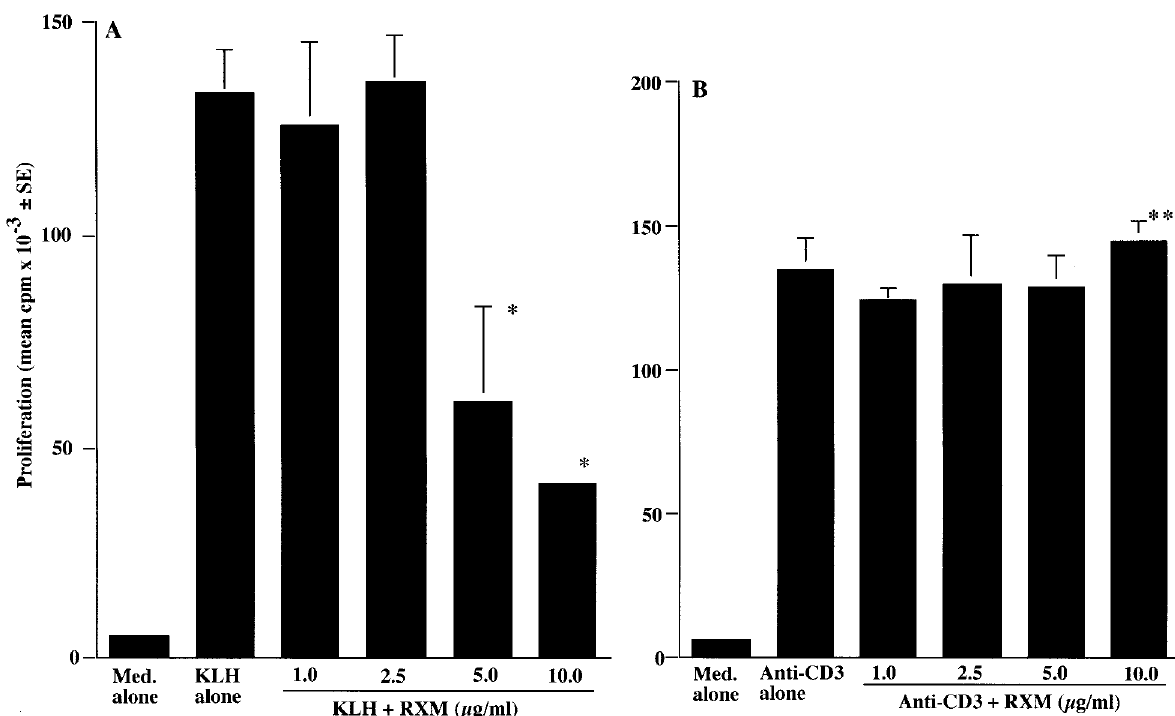
FIG. 1. Influence of RXM on antigen-induced proliferative response of splenic lymphocytes. BALB/c mice were immunized by intraperitoneal injection with 8.0 m g/ml of hemocyanin KLH absorbed to 4.0mg of aluminum hydroxide in a volume of 0.5ml. Spleen cells (1 ´ 10 5 cells/0.1ml) prepared from mice 10 days later were cultured in the presence of various concentrations of RXM for 72h, which were stimulated with 100.0 m g/ml of KLH (A). Splenic T cells (2 ´ 10 5 cells/0.1ml) were also cultured with immorbilized anti-CD3 « monoclonal antibody in the presence of various concentrations of RXM for 72h (B). The cell proliferation was assessed by measuring incorporation of 1.0 m Ci of 3 H-thymidine for 8h. The results are expressed as mean cpm ± standard error of five individual mice. * Significant at p < 0.05 as compared with KLH alone, ** not significant ( p > 0.05) as compared with anti-CD3 alone.